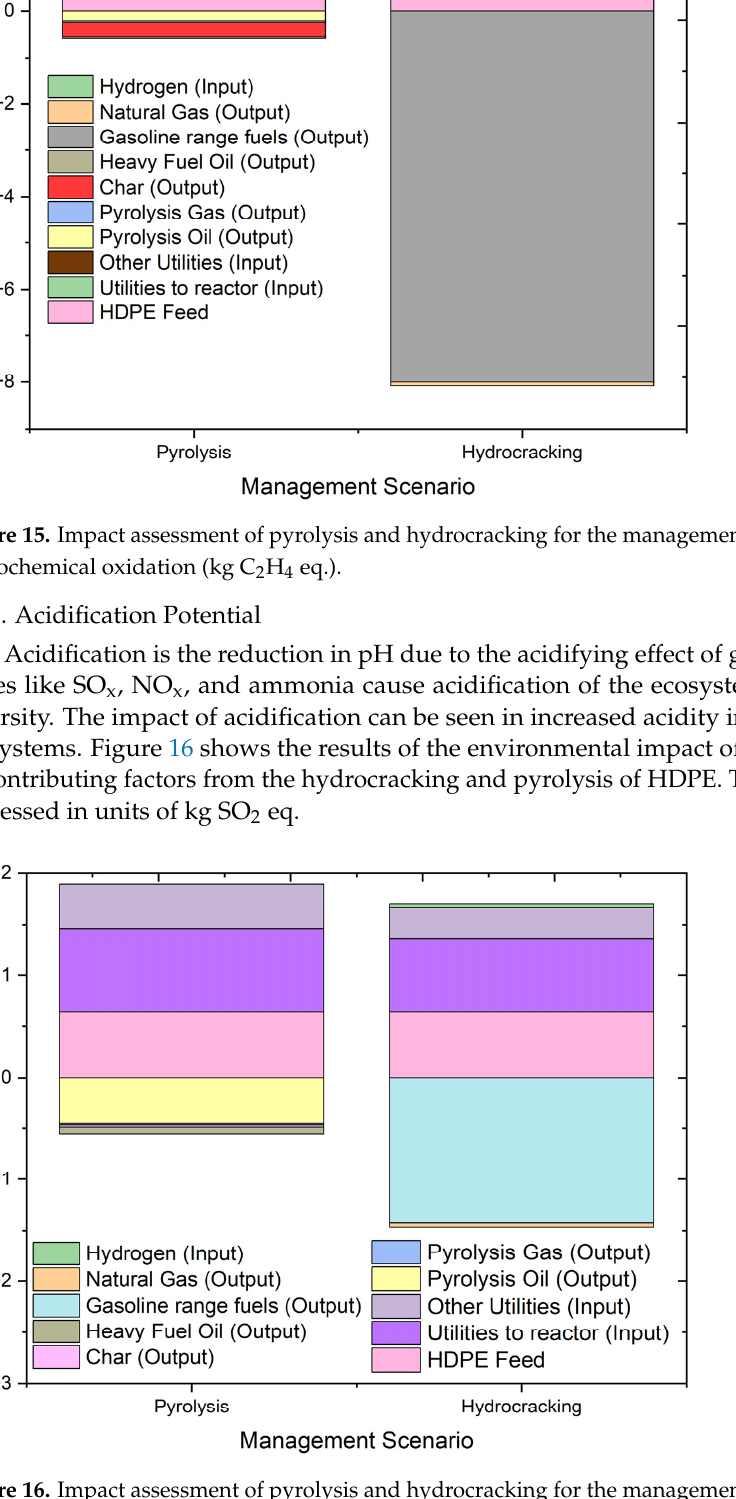
Figure 16. Impact assessment of pyrolysis and hydrocracking for the management of waste HDPE on acidification potential (kg SO 2 eq.).